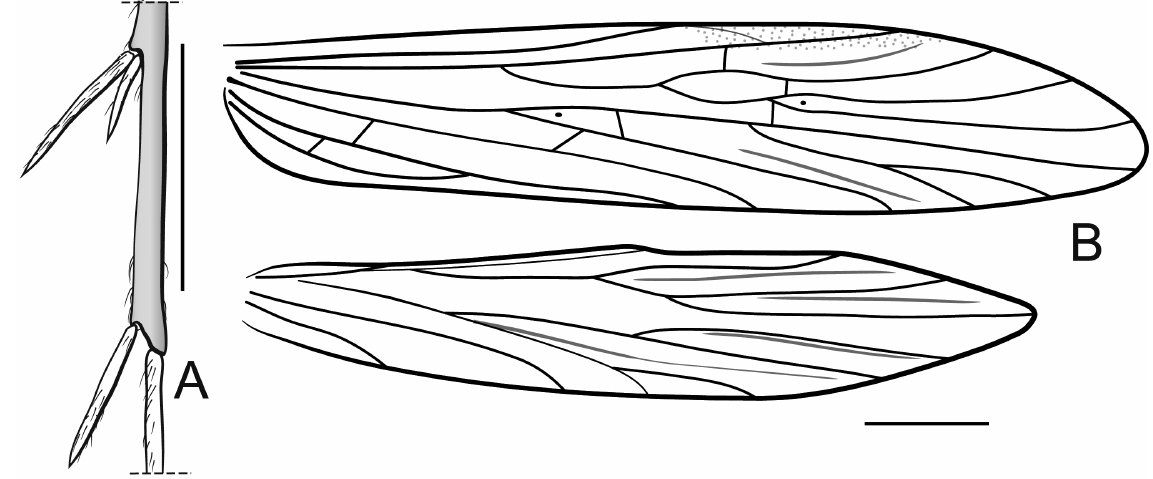
Fig. 4. Xiphocentron ( Antillotrichia ) maracanan sp. nov., holotype, adult, ♂. A . Tibial spurs of the hind leg. B . Right wings, dorsal view. Scale bars = 0.5